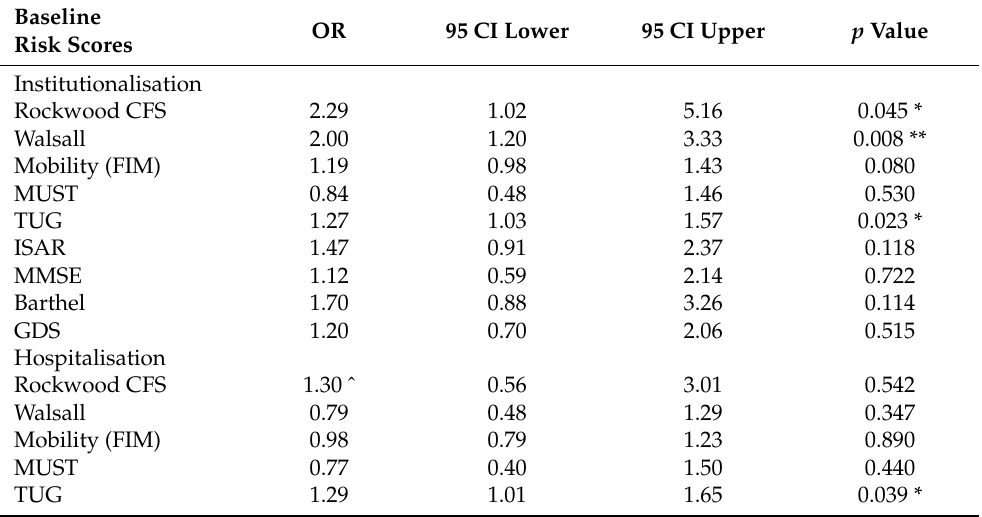
Table 7. Adjusted odds ratio (OR) with 95% confidence intervals (CI) for risk of institutionalisation, hospitalisation and death associated with each baseline risk score; n =